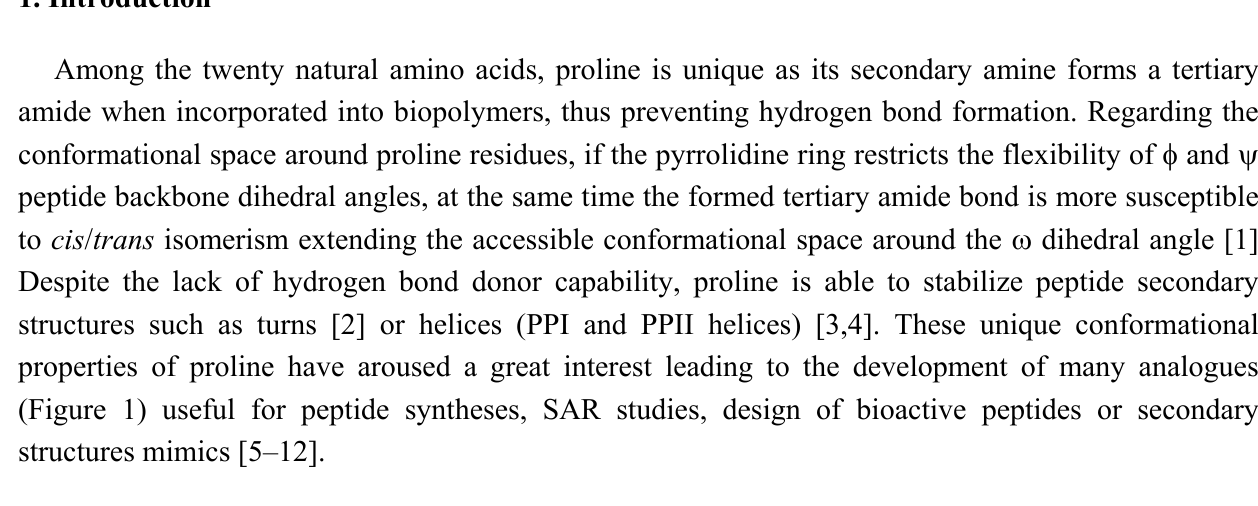
Figure 1. Some proline